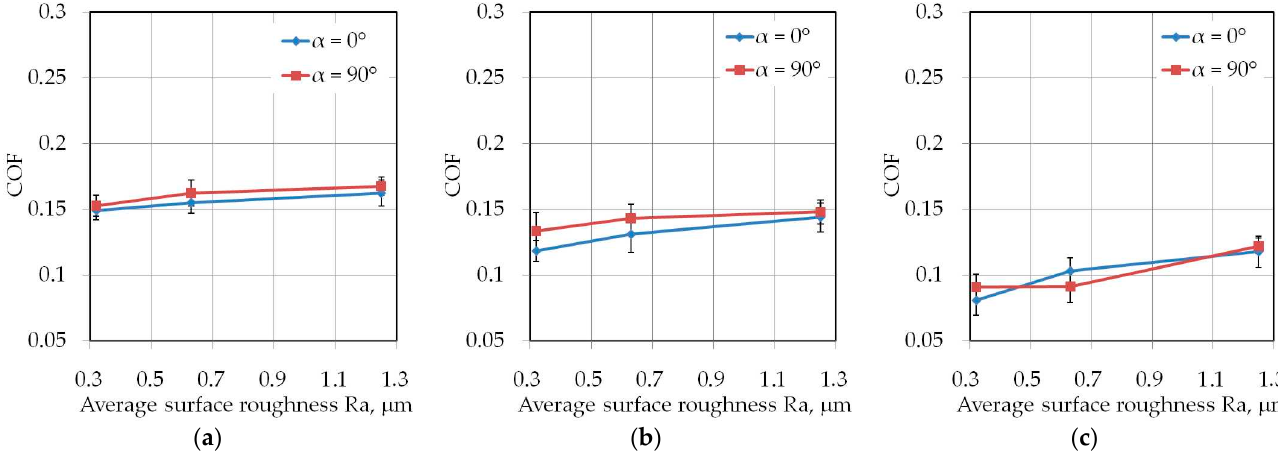
Figure 15. The effect of the sample orientation on the value of COF for specimens with a width of 14 mm tested at HD 1150 compound lubrication conditions: ( a ) h = 6 mm, ( b ) h = 12 mm, ( c ) h = 18